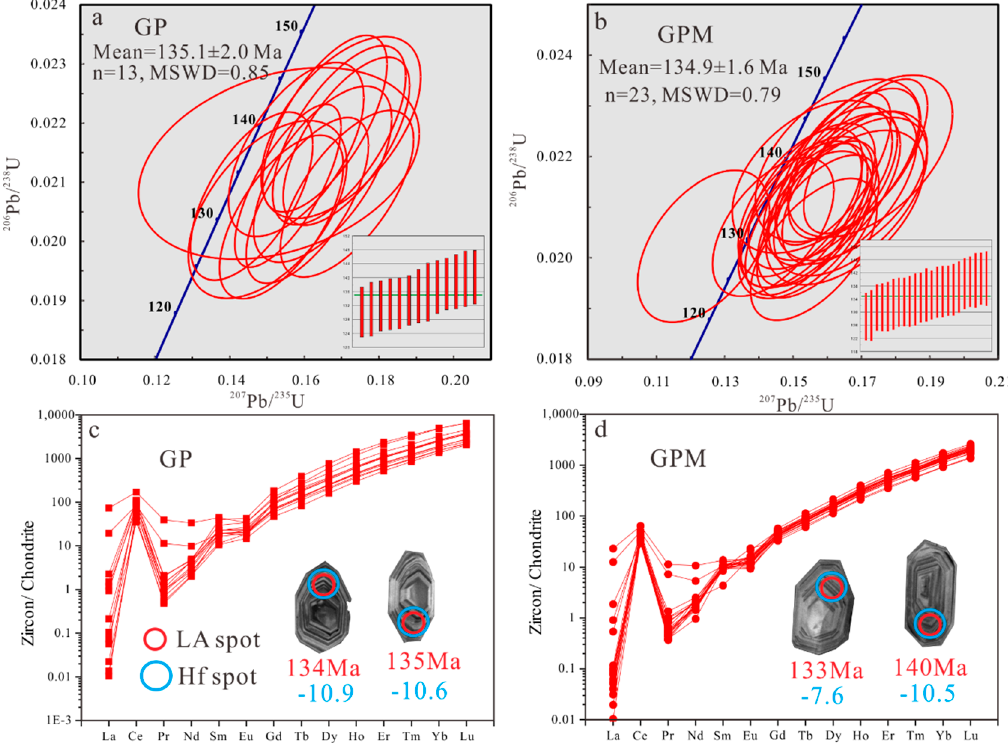
Figure 9. ( a ) Zircon U–Pb Concordia diagrams and ( b ) weighted average diagrams of the intrusions in Qiaomaishan. ( c ) representative CL images and ( d ) REE distribution patterns of zircons in the Qiaomaishan intrusions. LA (U–Pb and REE) spots: red circles; Hf spots: blue circles.